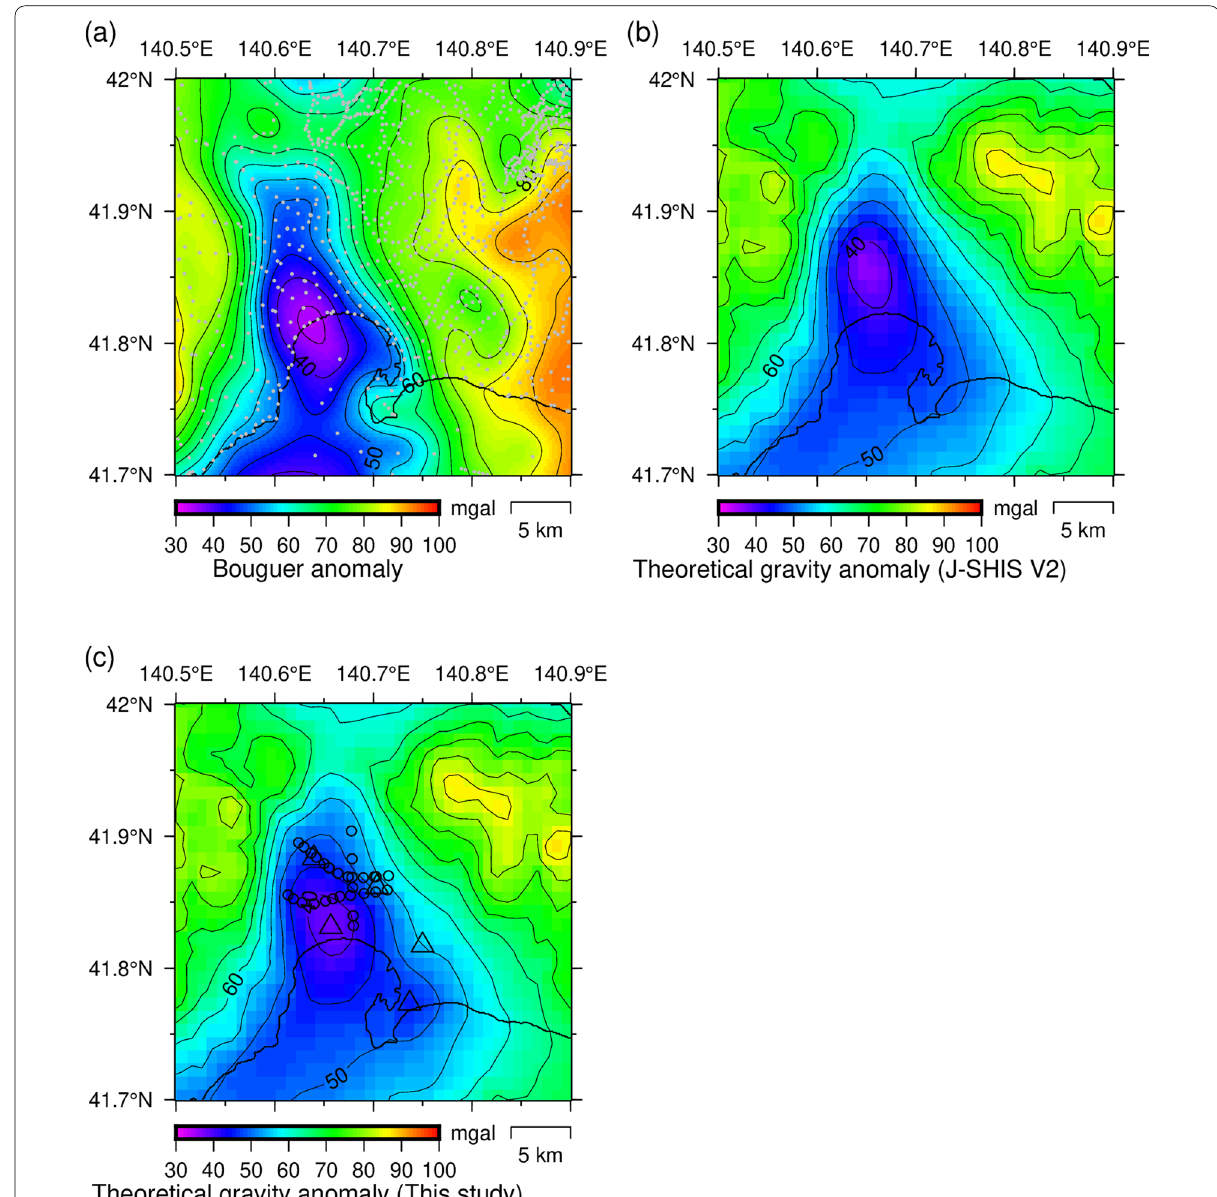
Fig. 9 Bouguer gravity anomaly in the Hakodate Plain. a The Bouguer anomaly map drawn utilizing the Gravity database of Japan (GSJ 2013). The assumed density is 2.30 g/cm 3 . The small dots represent gravity observation points collected in the database. b The theoretical gravity anomaly based on the J-SHIS V2 model (Fujiwara et al. 2012). c The theoretical gravity anomaly map based on the new velocity structure model of this study. The open triangles and open circles indicate the control points for the mictotremor array surveys and the reflection surveys,